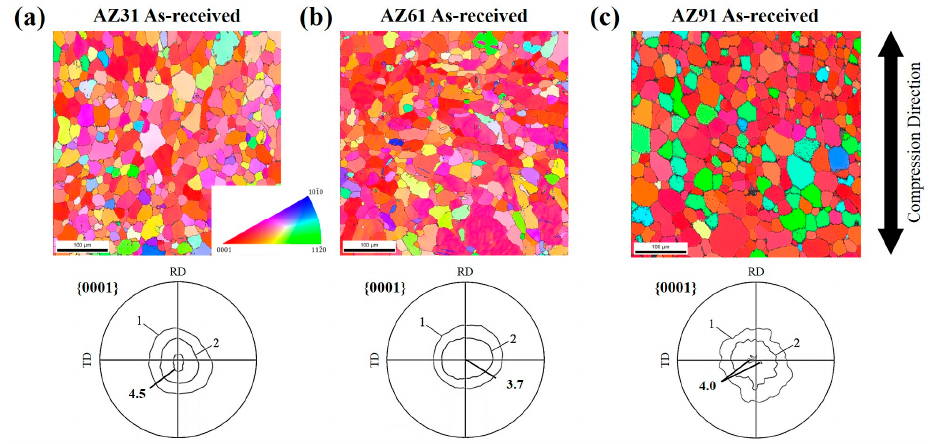
Figure 1. The microstructures and (0001) pole fi gures of three types of specimens before defor- mation: ( a – c ) AZ31, AZ61, and AZ91. The pole densities are projected onto the compression plane, and the mean density is used as a unit.